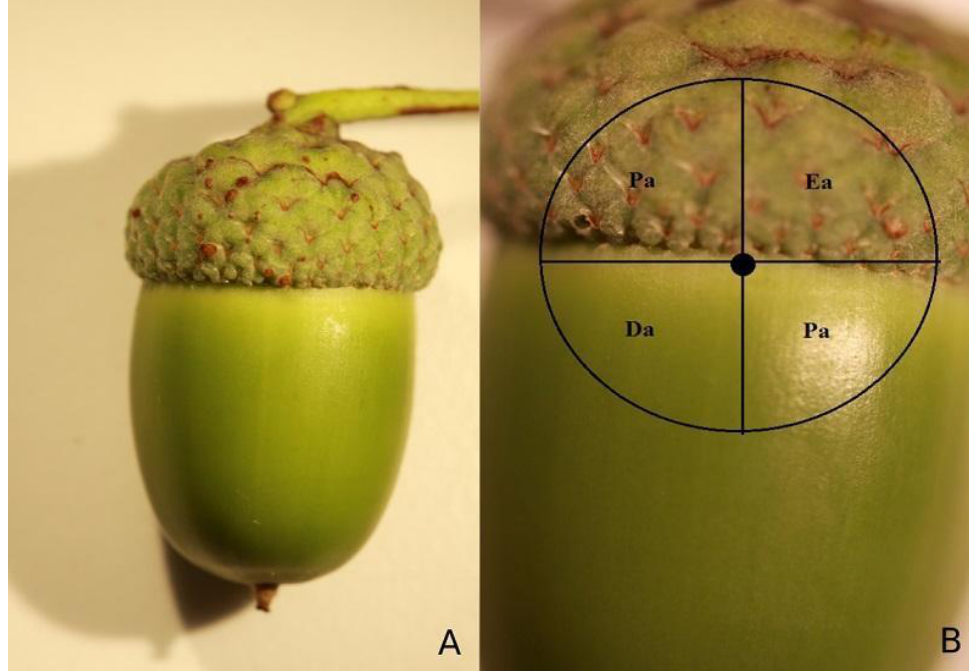
Figure 1. Scheme of egg distribution in an acorn: ( A ) general view of a fruit, ( B ) close up with marked egg areas: Ea —egg area, where the first egg was laid; Pa —proximate area, i.e., locations close to laid egg; Da —distant area, which was more than 45° from laid egg.